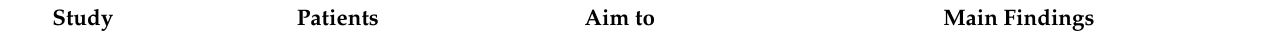
Table 2. Recent studies exploring effects of multimorbidity on outcomes in older people with